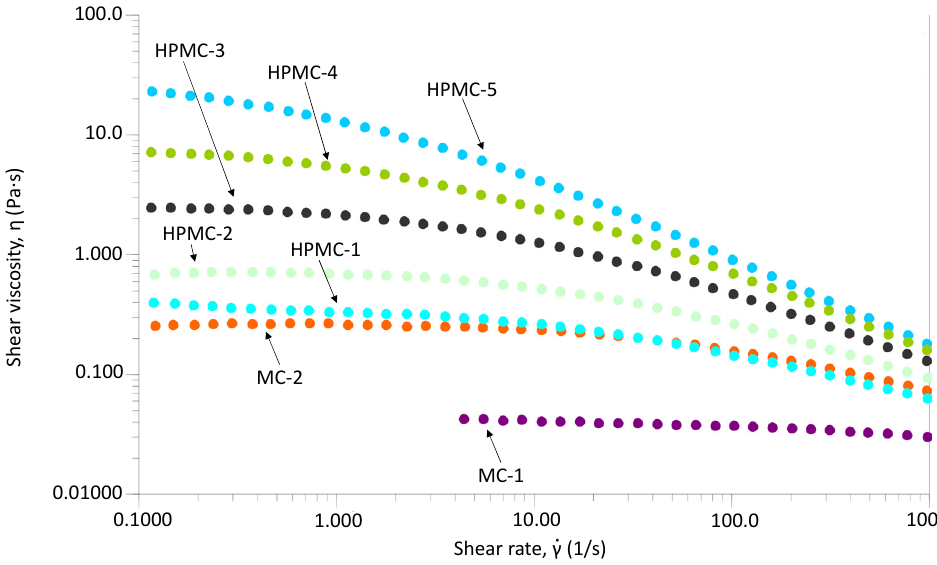
Figure 4. Shear viscosity plotted as a function of shear rate for variants of MC and HPMC.